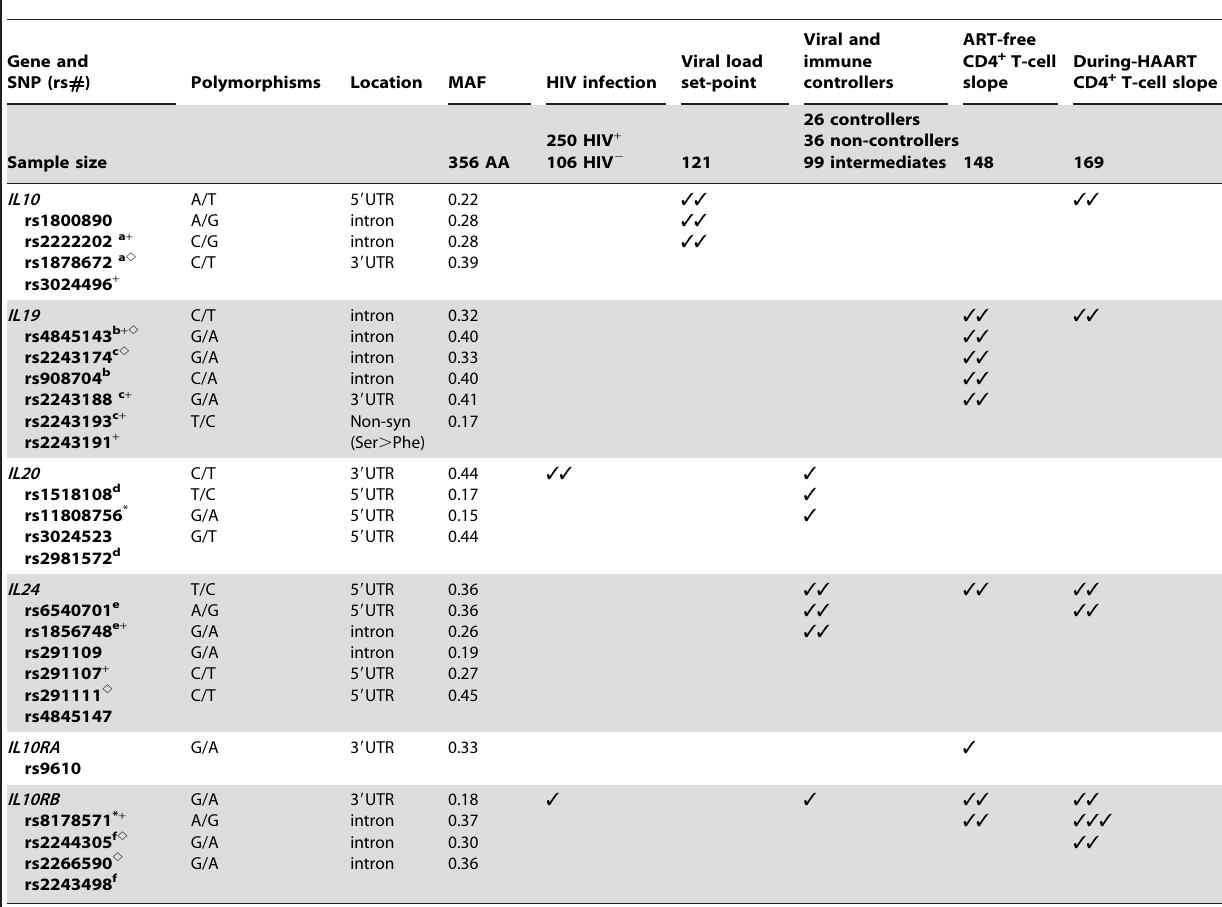
Table 4. Summary of genetic influence of IL10 gene family and various HIV infection